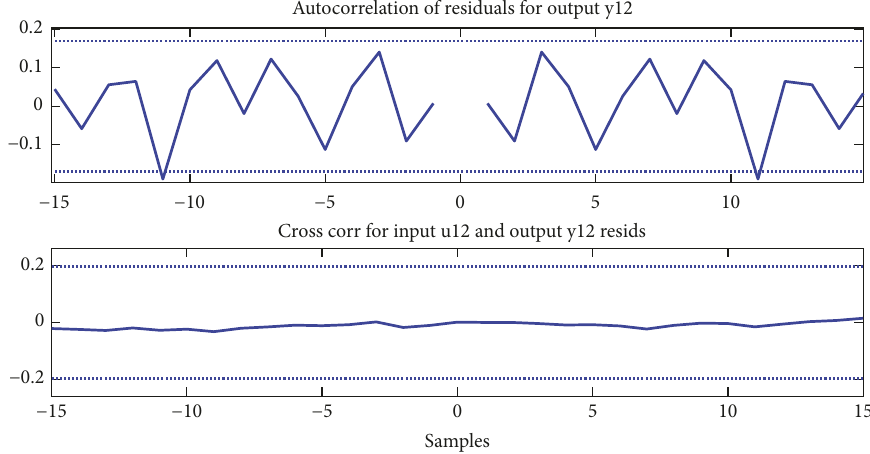
Figure 29: Autocorrelation y12 and cross-correlation of system responses u12 &